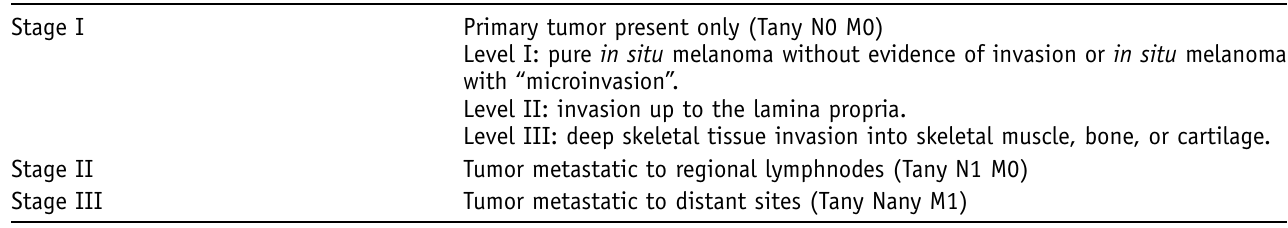
Table 1. Clinical staging system for oral malignant melanoma with histopathologic microstaging for stage I (Prasad [20]).